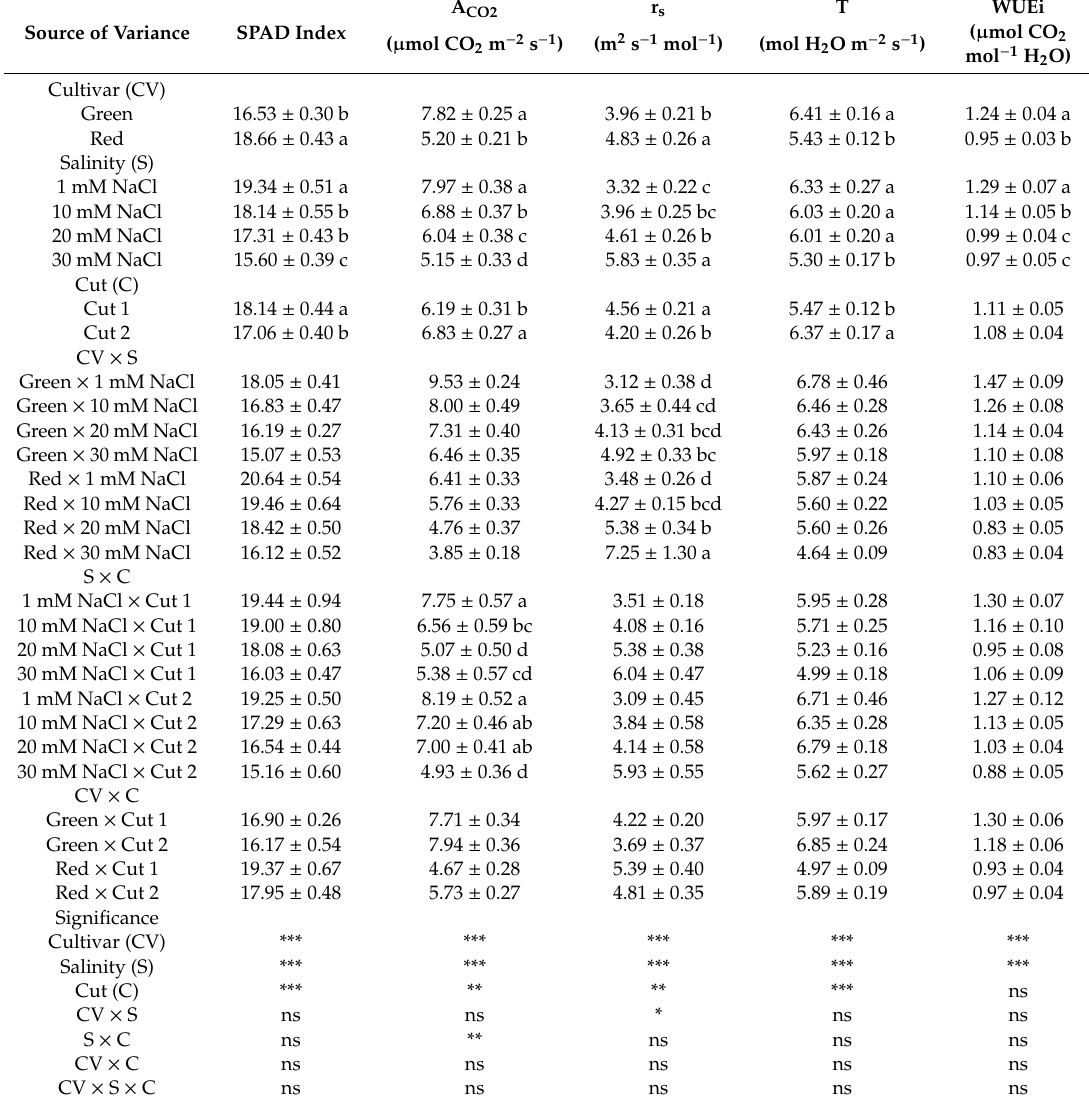
Table 3. Significance of the main factors (cultivar, salinity and cut order) and their interactions on SPAD index, net photosynthetic CO 2 assimilation rate[A CO2 ], stomatal resistance [r s ], transpiration [T] and intrinsic water use e ffi ciency [WUE i ] of Lactuca sativa L. var. acephala grown in a floating raft